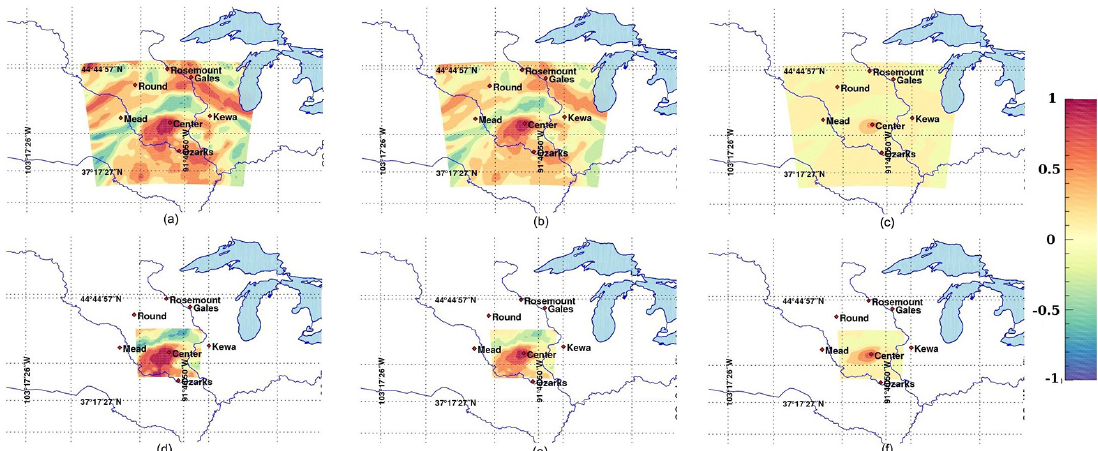
Figure 7. Hourly raw (a, d) and filtered correlations using Schur (b, e) and Wiener (c, f) filtered correlations of in situ CO 2 mole fractions at the Centerville tower (at about 100ma.g.l.) on 26 June 2008. The correlations are based on the original 45-member ensemble (a, b, c) with a large subdomain (900km × 900km) and the 25-member ensemble (d, e, f) over the reference subdomain (400km × 400km). The highlighted domain also corresponds to the domain used for the spatial averaging of the correlations in the optimality conditions.